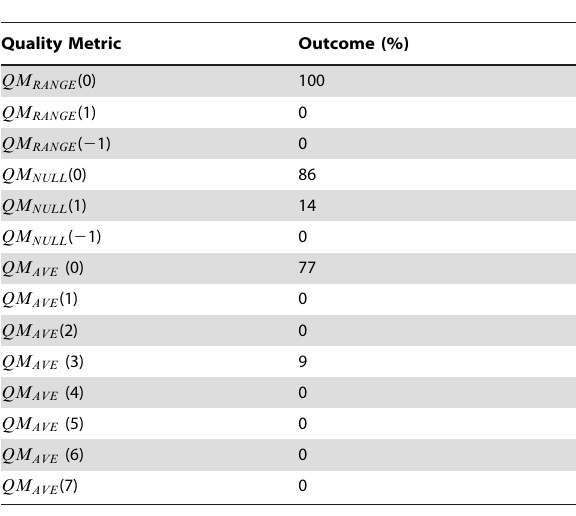
Table 5. The associated quality metrics for the 10-minute TRAAT